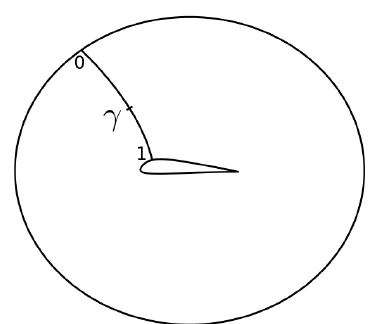
Figure 1. Example spline from the airfoil to the far field with interpolation factor γ